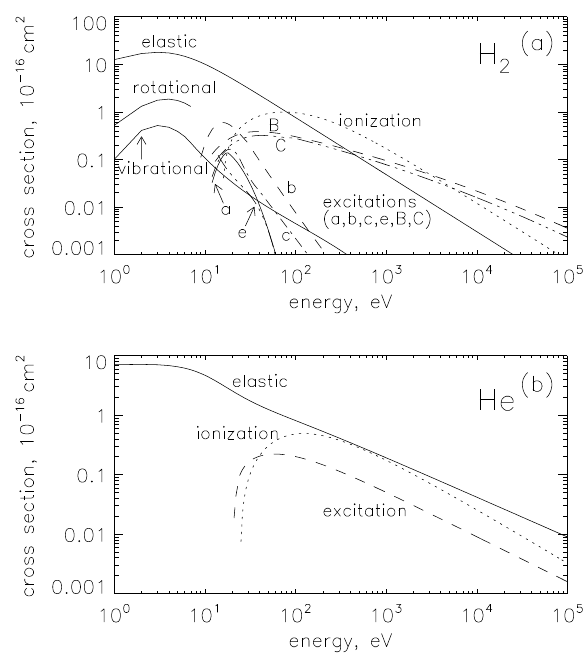
Figure 12: 2007.12.18: Y. Hiraki and C. Tao Fig. 12. Electron impact cross sections of (a) H 2 and (b) He for